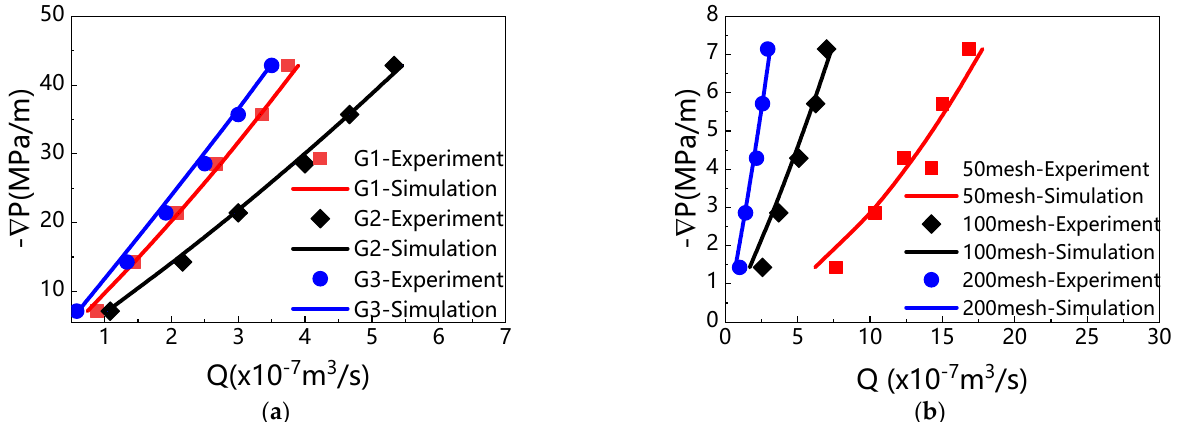
Figure 9. Comparison of the experimental results with the numerical code results: ( a ) unfilled condition and ( b ) filled conditions of G3.